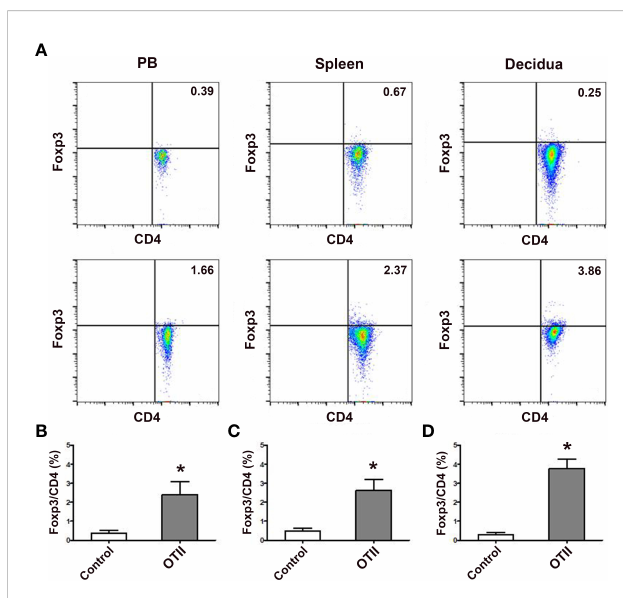
FIGURE 5 Fetal antigen induced pTreg cell generation in vivo . (A) Representative fl ow cytometry experiments of in vivo generated CD4 + GFP + Treg cells from naïve T cells of female Foxp3 GFP mice (upper row) or OT- IIFoxp3 GFP mice (lower row) in the peripheral blood, spleens and deciduae of pregnant C57BL/6 mice mated to Act-mOVA mice are shown. Levels of in vivo generated CD4 + GFP + Treg cells in the peripheral blood (B) , spleens (C) and deciduae (D) of pregnant C57BL/ 6 mice mated to Act-mOVA mice are shown. Data are presented as mean ± SD (n = 6). * p < 0.01 vs the control group.